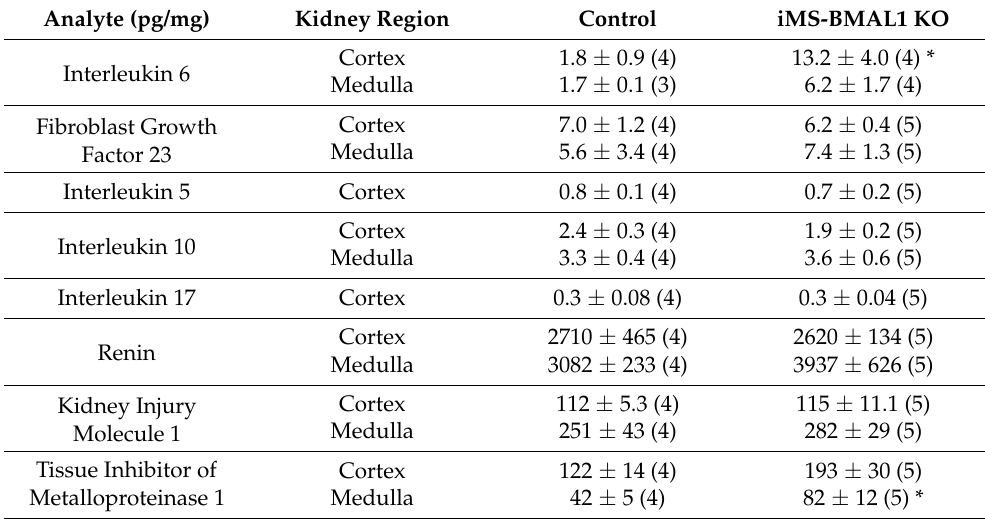
Table 1. Analytes measured via multiplex immunoassays in renal cortical and medullary tissue from control and iMS-BMAL1 KO mice following phase advance. Values are mean ± SEM with (number of animals per group). Student’s t